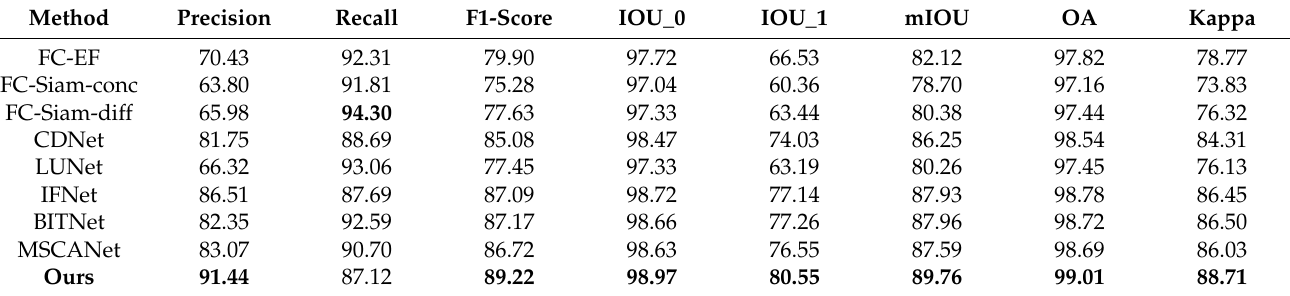
Table 5. Quantitative comparisons of various CD methods from the WHU-CD